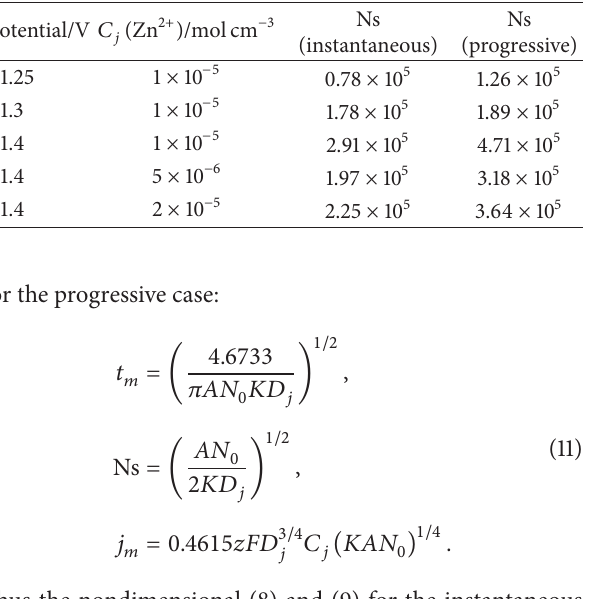
Table 1: The values of nucleation kinetic parameter Ns for each concentration and potential.